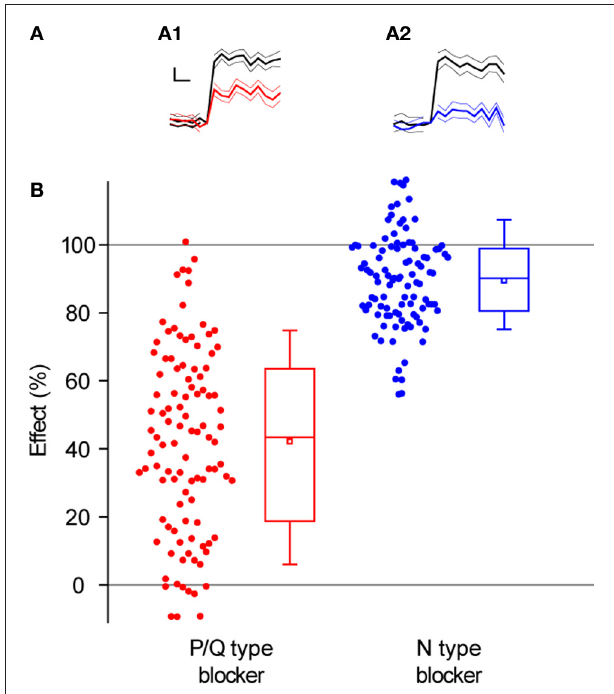
FIGURE 4 | Block of P/Q-type Ca 2 + channels leads to weaker and more variable decrease of exocytosis than block of N-type Ca 2 + channels. (A) Representative single synapse responses to 1 AP stimulus before and after the application of toxins that block Ca 2 + channel subtypes. (A1) Response to 1 AP before (black) and after (red) applying ω -agatoxin IVA (effect of toxin = 45 ± 12%). (A2) Response to 1 AP before (black) and after (blue) applying of ω -conotoxin GVIA (effect of toxin = 81 ± 11%). Each trace in (A1) and (A2) is an average of 30 trials with the thinner lines representing the SEs. Traces are normalized to the size of the response before applying the corresponding toxin and shown on the same scale. Scale bar: 0.2 s and 20% of pre-toxin response. (B) Effect of P/Q and N-type Ca 2 + channel blockers across all synapses. The effect of a toxin is defined as the percentage decrease in single AP responses. Each dot corresponds to one synapse. Box whisker plots show the median (line), mean (point), 25–75 percentile (box), and 10–90 percentile (whisker) ranges ( n = 103 synapses from 9 experiments for P/Q-type blocker, 101 synapses from 8 experiments for N-type